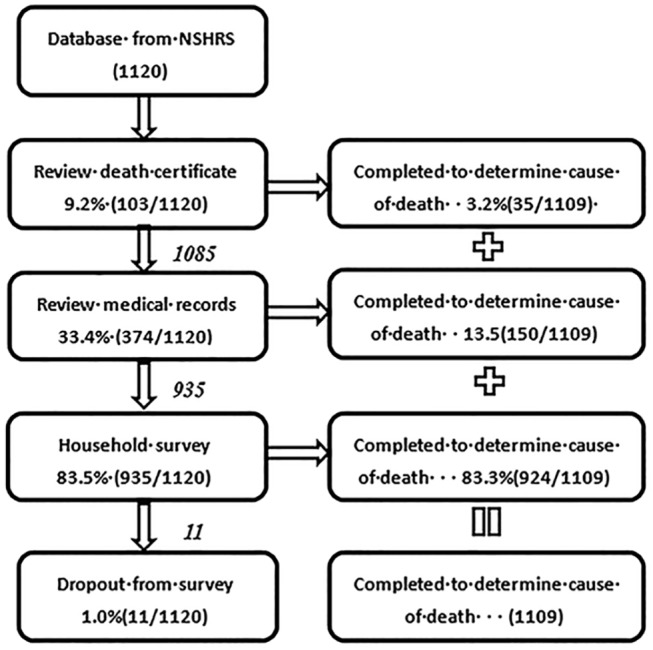
Flow chart of data collection procedure.